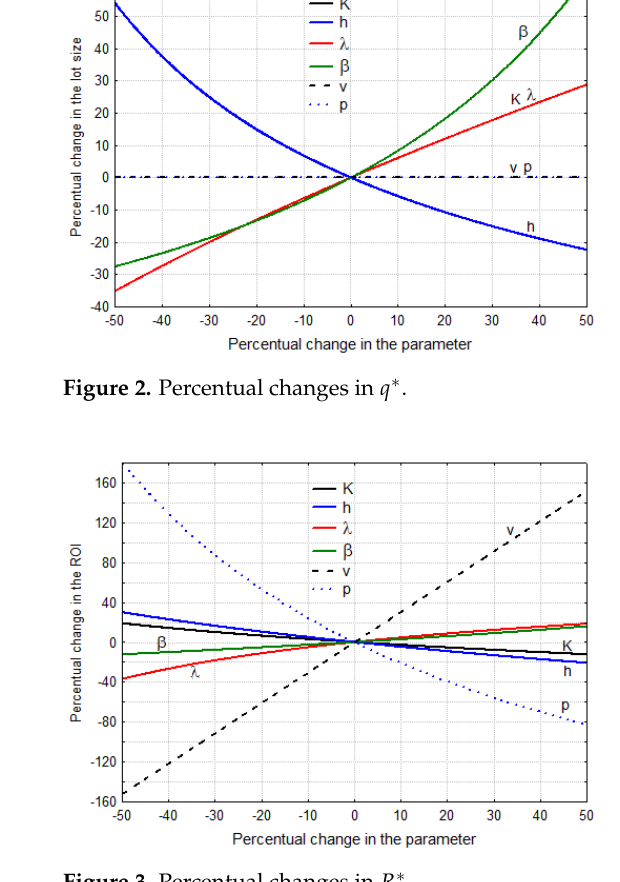
Figure 3. Percentual changes in R ∗